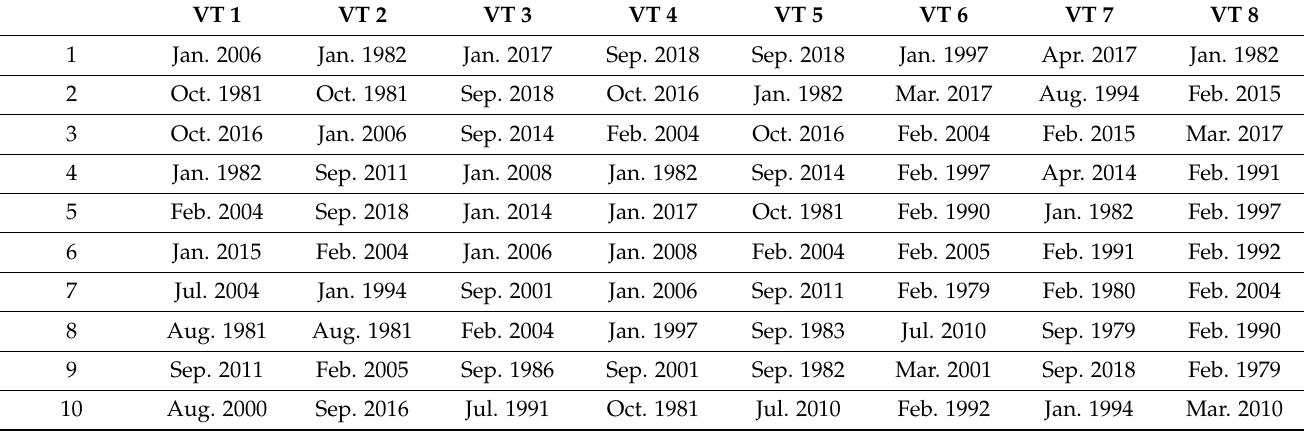
Table A2. Observation dates of the ten minimum ∆ S cases for each vegetation type in Figure